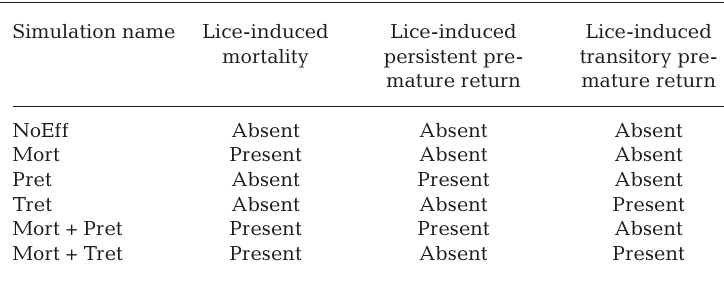
Table 5. Simulations run to investigate the effect of different responses to lice